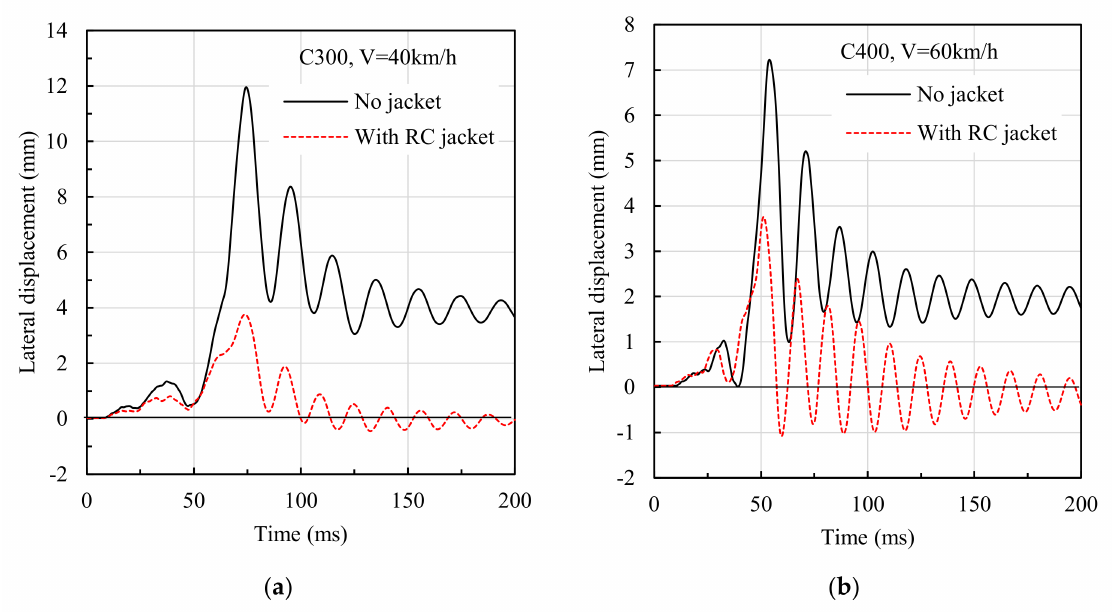
Figure 19. Displacement history of columns with an RC jacket with φ 10@150 mm shear reinforcement up to 1.3 m height of the column: ( a ) column size 300 × 300 mm and impact velocity of 40 km/h; ( b ) column size 400 × 400 mm and impact velocity of 60